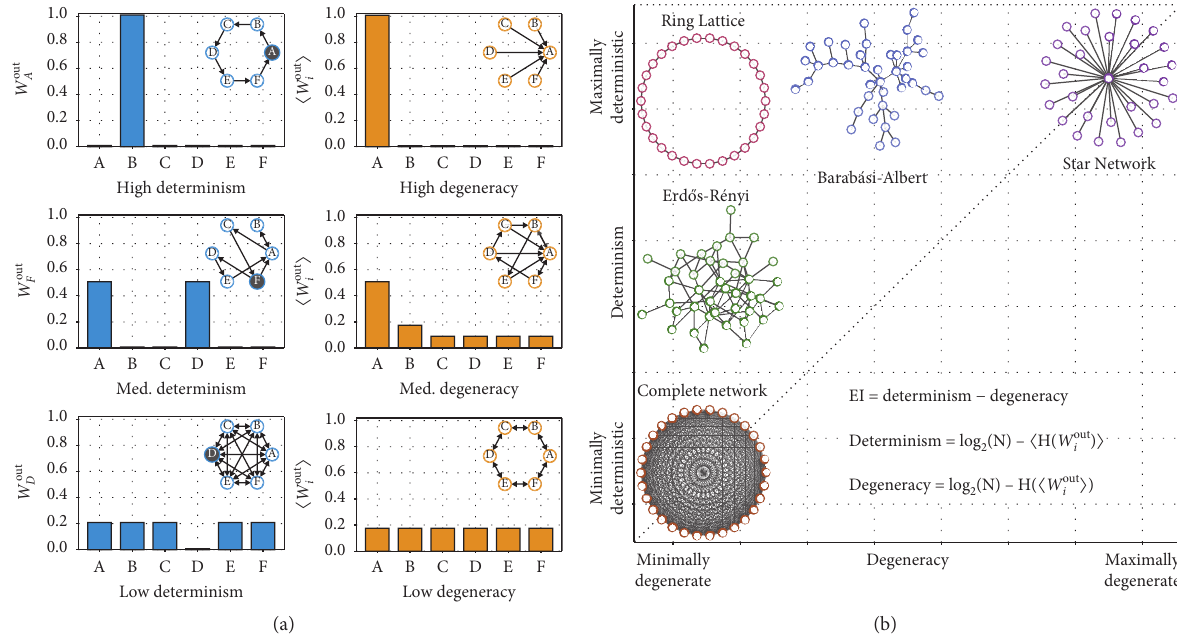
Figure 2: Comparing determinism and degeneracy. (a) Left column: three example out-weight vectors, W out maximally deterministic vector (top left, where the W out A corresponds to node A in the inset network motif) is when a random walker on v i transitions to one of its neighbors with probability 1.0, whereas indeterminism occurs when v i has a uniform probability of visiting any node in the network in the next time step. Right: three example in-weight vectors to a given v j . A maximally degenerate vector, 〈 W out i 〉 (top right, exemplified by the inset network motif), is when every outgoing edge in the network connects to a single node, whereas minimal degeneracy occurs when each value in 〈 W out i 〉 is uniformly ( 1/ N ) . (b) By comparing the determinism and degeneracy of canonical network structures, we find a great deal of heterogeneity in different network models’ ratios between their determinism and degeneracy. High degeneracy is characterized by hub-and-spoke topology, as in the case of the star network. Networks with high determinism are characterized by longer average path lengths, as in the case of a ring